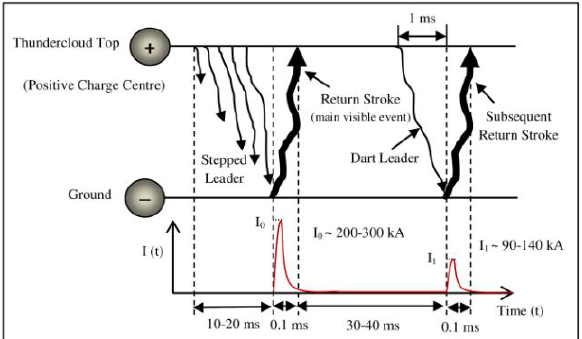
Fig. 2. Mechanism of positive cloud-to-ground lightning